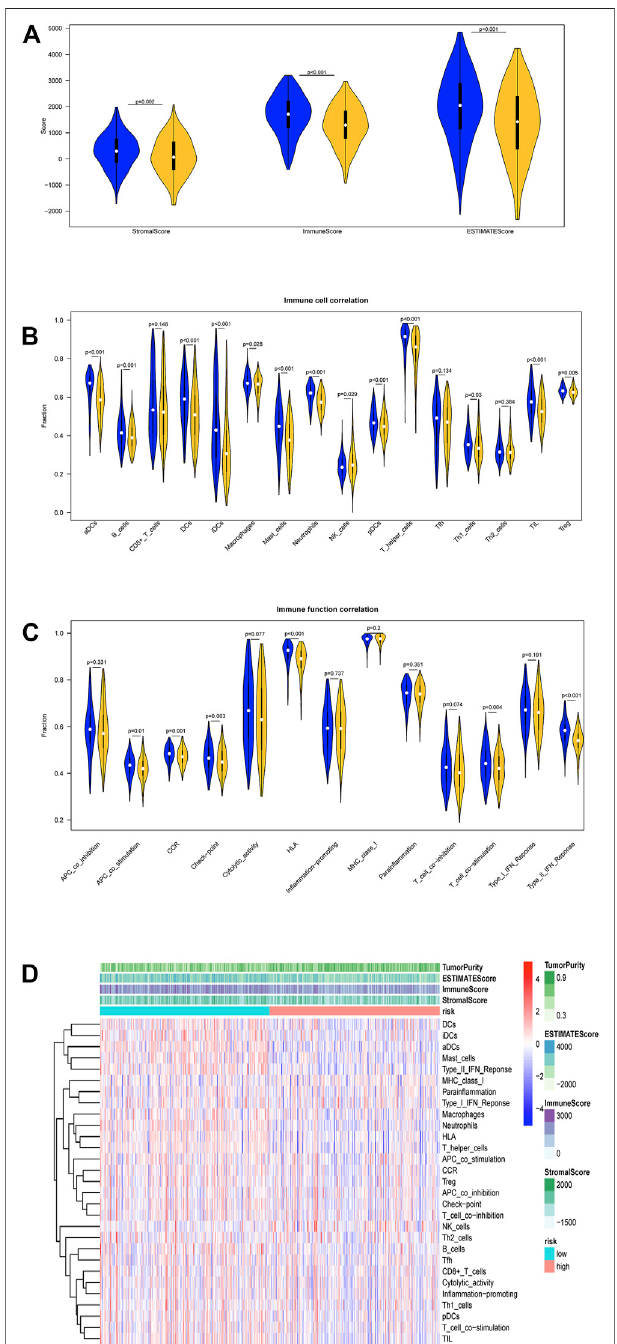
FIGURE 6| Analysisof differences in immunein fi ltration in twogroups in TCGA-LUAD dataset. (A) Differential expression analysis on stromal score, immune score, and ESTIMATE score in the high- and low-risk groups. Blue: low-risk group, red: high-risk group. (B) Enrichment levels of 29immune-relatedcellsandtypesintwogroups.Tumorpurity,stromalscore, immune score, and ESTIMATE score of each patient in two groups. (C) Analysis of differences in immune cell in fi ltration levels in two groups. Blue: low-risk group, red: high-risk group. (D) Analysis of differences in each immune function in two groups. Blue: low-risk group. Red: high-risk group.